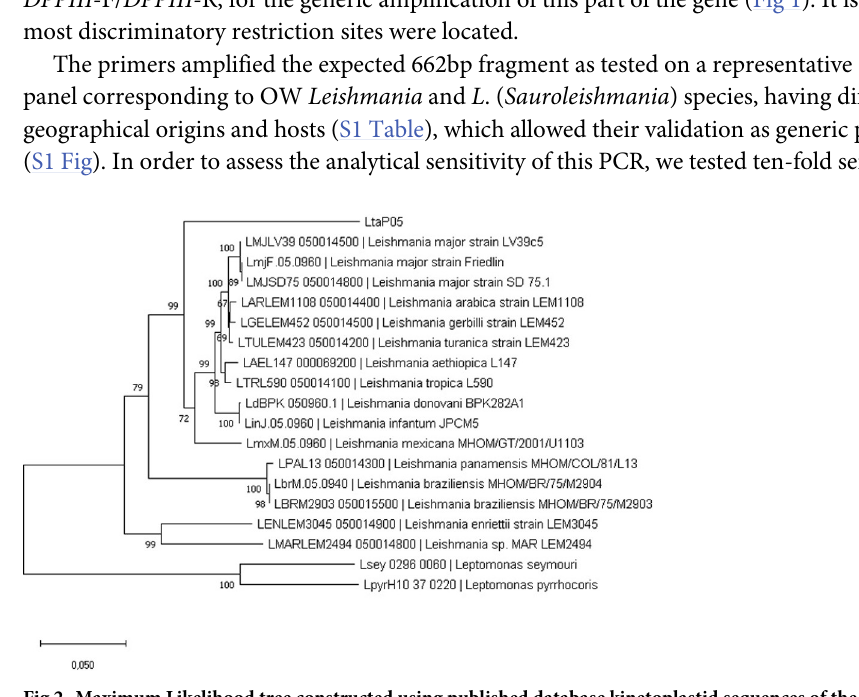
Fig 2. Maximum Likelihood tree constructed using published database kinetoplastid sequences of the entire DPPIII gene. The evolutionary history of Leishmania parasites was inferred using the Maximum Likelihood method and Tamura-Nei model. The tree with the highest log likelihood (-8661.86) is shown. Initial tree(s) for the heuristic search were obtained automatically by applying Neighbor-Join and BioNJ algorithms to a matrix of pairwise distances estimated using the Tamura-Nei model, and then selecting the topology with superior log likelihood value. A discrete Gamma distribution was used to model evolutionary rate differences among sites (5 categories (+G, parameter = 0.4323)). The tree is drawn to scale, with branch lengths measured in the number of substitutions per site. This analysis involved 19 nucleotide sequences. Codon positions included were 1st+2nd+3rd+Noncoding. There were a total of 2046 positions in the final dataset. Evolutionary analyses were conducted in MEGA